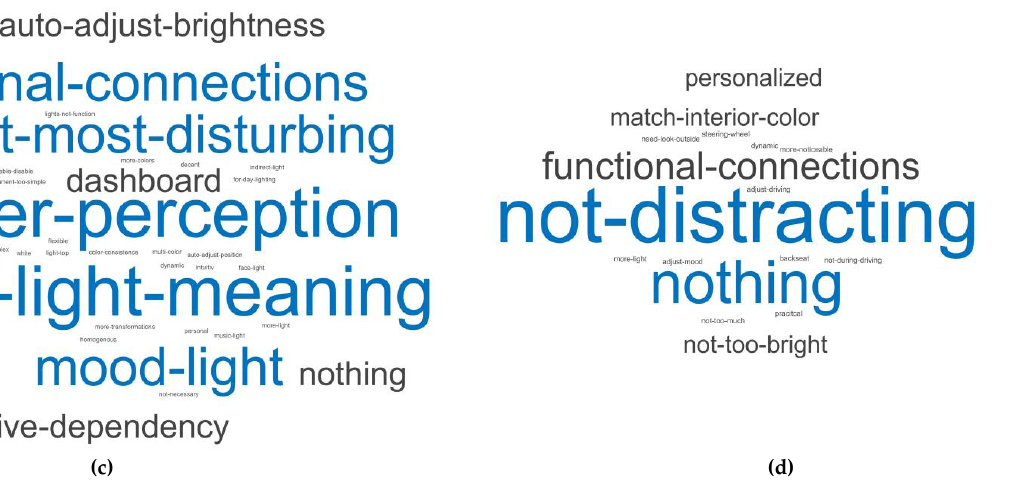
Figure 10. Word cloud results displayed for Q 1 as “Which light system do you want to have in your future vehicle?” in ( a , b ). For Q 2 as “If you don’t like your current interior lighting in your vehicle, which proposals you have to improve it?” in ( c , d ). Results are separated by genders globally. Amount n of participants for each question: ( a ) male answers with n = 59; ( b ) female answers with n = 47; ( c ) male answers with n = 36; ( d ) female answers n =